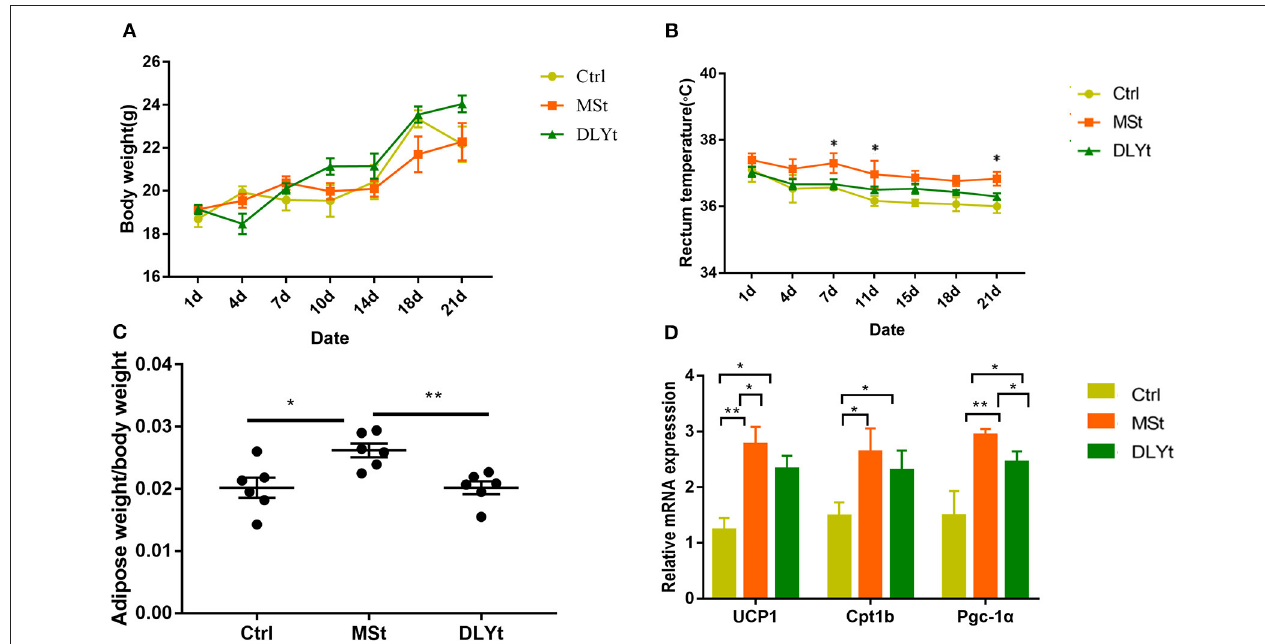
FIGURE 1 | Effect of fecal microbiota transplantation (FMT) on metabolic phenotypes and general immunity during cold exposure. (A–C) Body weight, body temperature ( n = 7/group), and adipose weight/body weight rate in FMT and control mice during cold exposure. (D) Results of relative gene messenger RNA (mRNA) of adipose thermogenesis ( n = 7/group). (* P < 0.05, ** P < 0.01, and *** P < 0.001, Duncan’s multiple range test). *** means extremely significant.